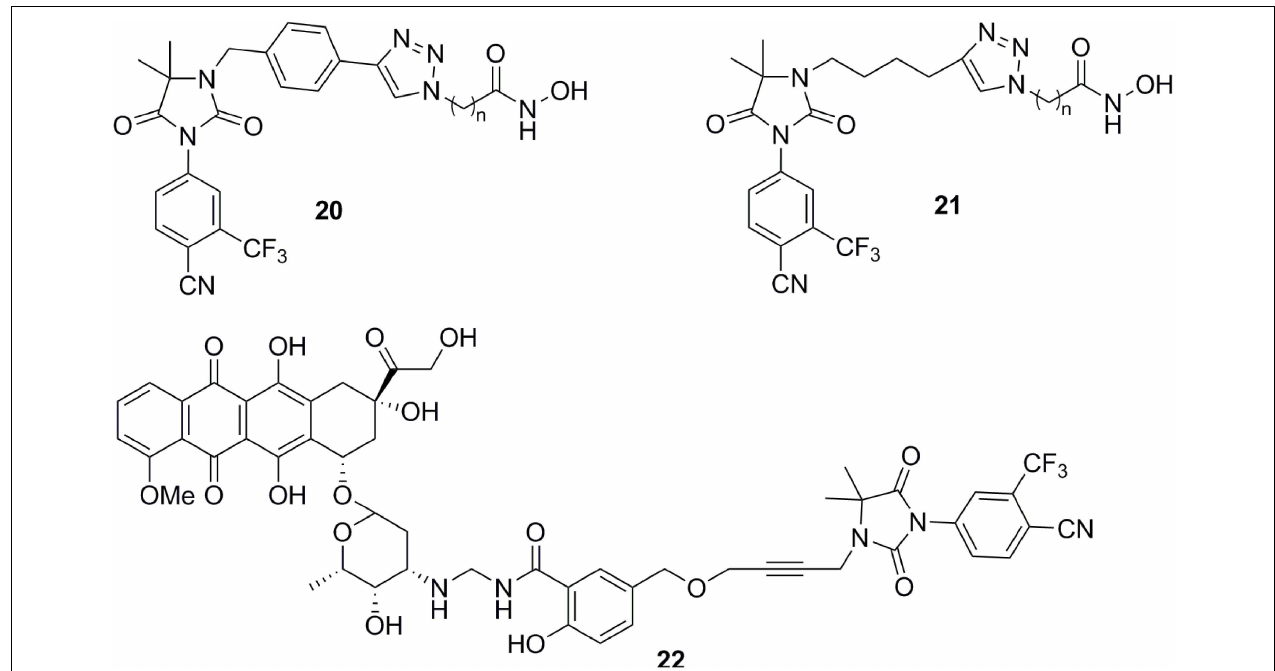
FIGURE 7 | Chemical structures of non-steroid conjugate AR